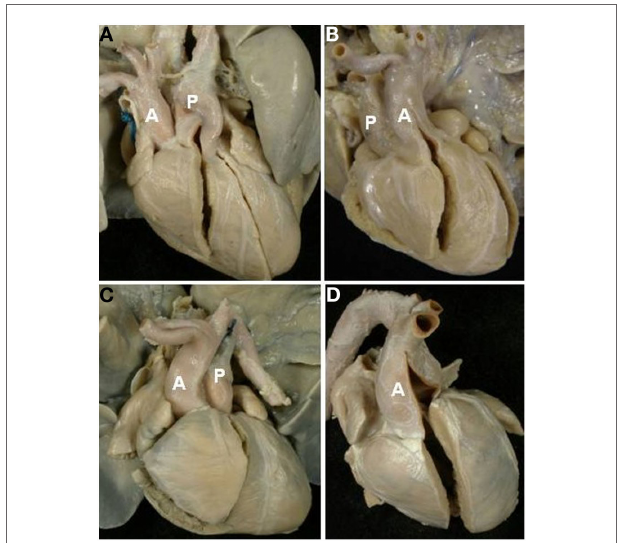
FigUre 3 | complete Tga: relation of the great arteries . Aorta in right posterior (a) , left anterior (B) , right anterior (c) , and anterior position (D) . A, aorta; P, pulmonary artery.